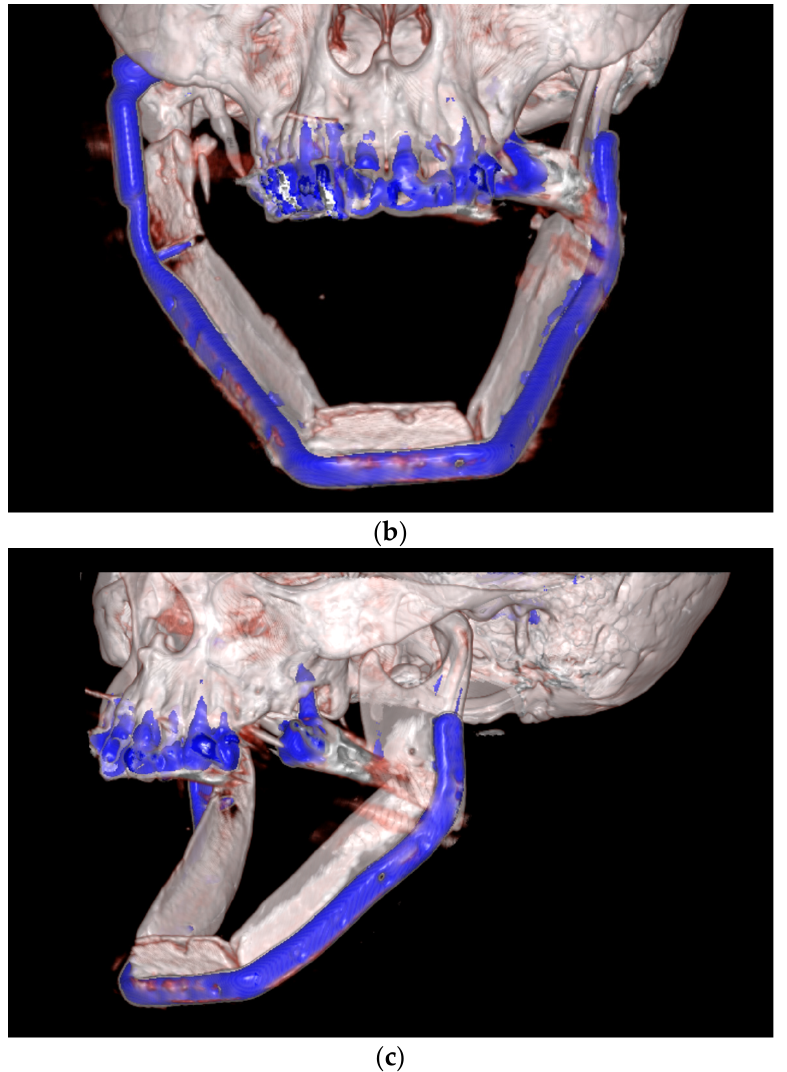
Figure 4. ( a – c ) shows the 3D reconstruction of the postoperative CT scan after resection and reconstruction of the mandible using free scapular flaps from both sides as virtually planned. The patient-specific implant is indicated in blue (along with the upper teeth).